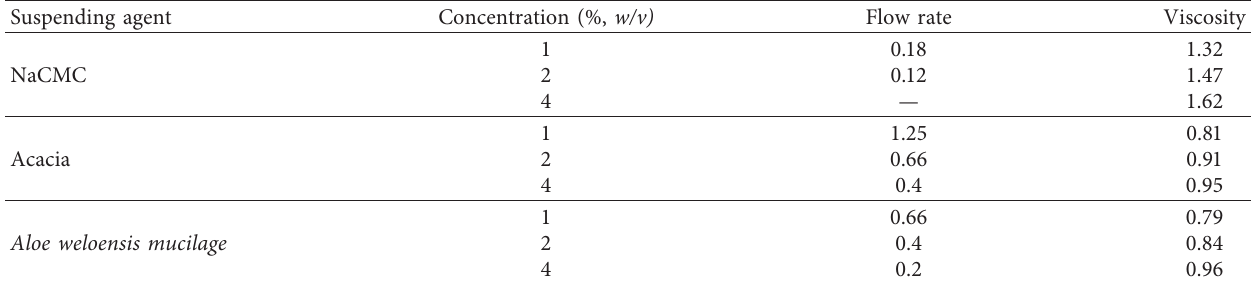
Table 4: Viscosity (poise) and flow rates (mL/sec) of ZnO suspensions prepared at different concentrations of Aloe weloensis mucilage, acacia, and NaCMC at room temperature.